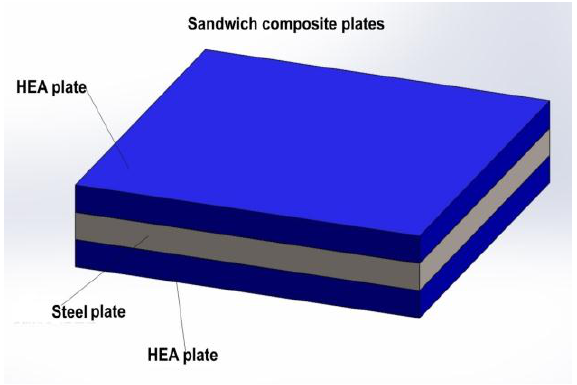
Figure 3. Composite plate obtained by brazing.